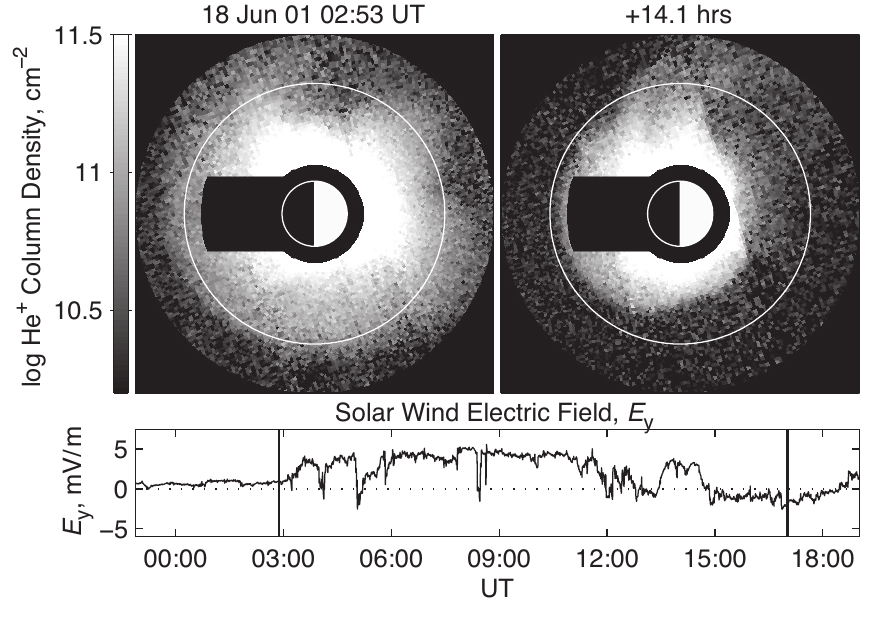
Fig. 1. Equatorially mapped EUV images of the plasmasphere before the disturbance onset (left) and at the beginning of the disturbance recovery (right) for 18 June 2001 with the sun being to the right of the images. The image has been masked out for L < 1 . 5, L > 5 . 5, and in the Earth’s shadow region. The white circle indicates L = 4. The images are calibrated and the gray scale indicates the log of the He + column density. The bottom panel is the solar wind electric field, E y , derived from ACE spacecraft measurements and the two vertical bars indicate the times of the two